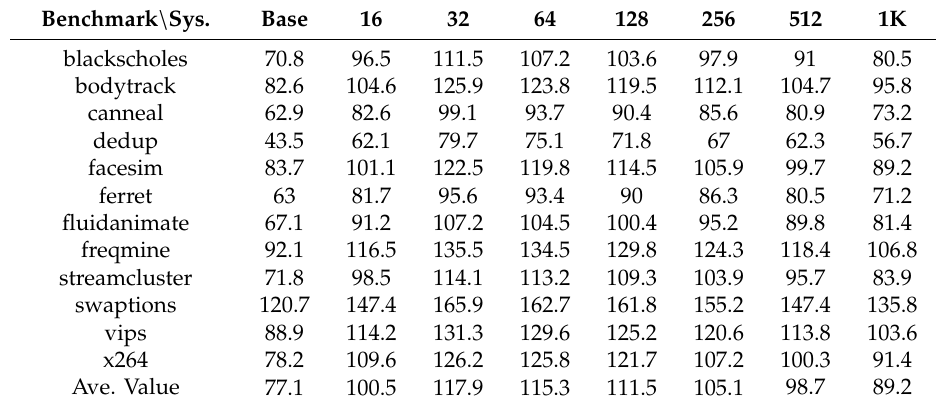
Table 4. Private cache throughput values of both base system and proposed system (Gbps stands for × 10 9 bits per second), where history bu ff er scale ranges from 16 to 1K entries 1 . Benchmark \